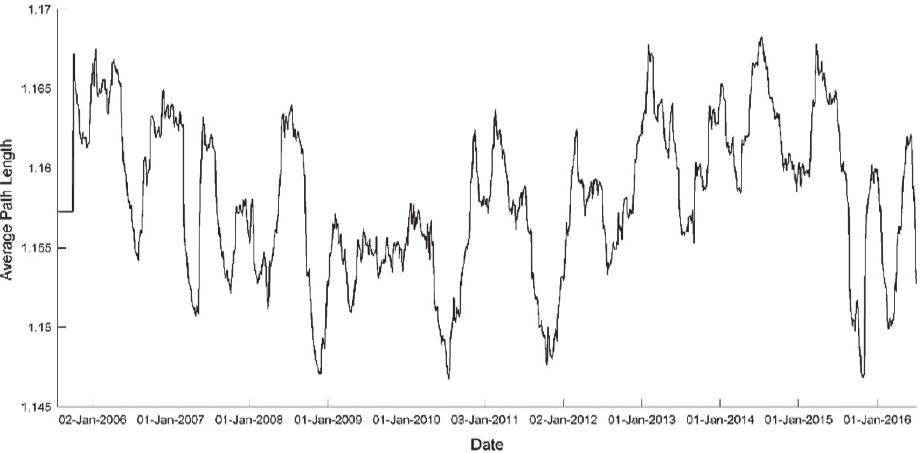
Fig. 3. Average path lengths of global stock